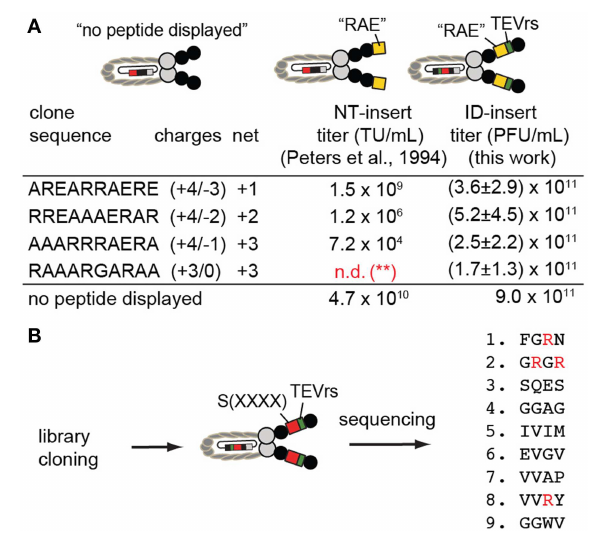
FIGURE 6 | (A) ID-PhD enhances the expression of positively charged peptide sequences. The data in “NT-insert”-column has been acquired by Dower and co-workers (Peters et al., 1994); it shows that Arg-rich “RAE”-sequences, when expressed at the N-terminus (NT) of pIII, impede phage titer by 2–6 orders of magnitude (TU = transducing units). We demonstrated that phage clones that display these sequences in the ID-format do not exhibit diminished titers; they are similar to the titer exhibited by phage without an insert (control phage labeled as “no peptide displayed”). Note that in experiments by Peters et al. (1994), control phage is FdTet phage displaying no N-terminal sequence. In our experiments, control phage is M13KE phage without ID-insert. The data is average and standard deviation from titer in three independent experiments. ( ** ): n.d., not determined; (B) We expressed the library of random tetrapeptides in ID-PhD format and, in preliminary low-throughput sequencing, observed a significant fraction of peptides with Arg. Abundance of Arg can be further validated in this library using next-generation